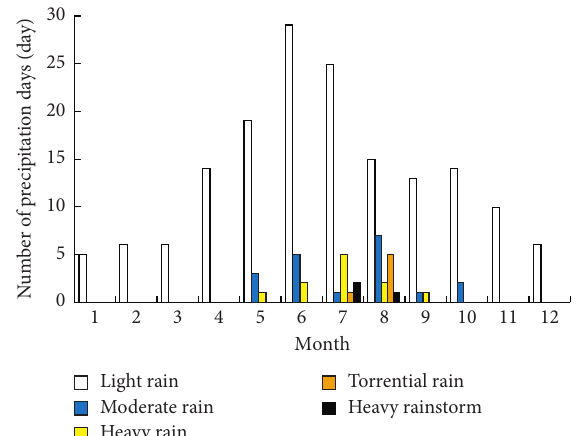
Figure 3: Histograms of the total of monthly averaged rainy days in Qinhuangdao for the period 2016–2018 by precipitation density: light (white hollow column), moderate (blue column), heavy rain (yellow column), torrential rain (orange column), and heavy rainstorm (black